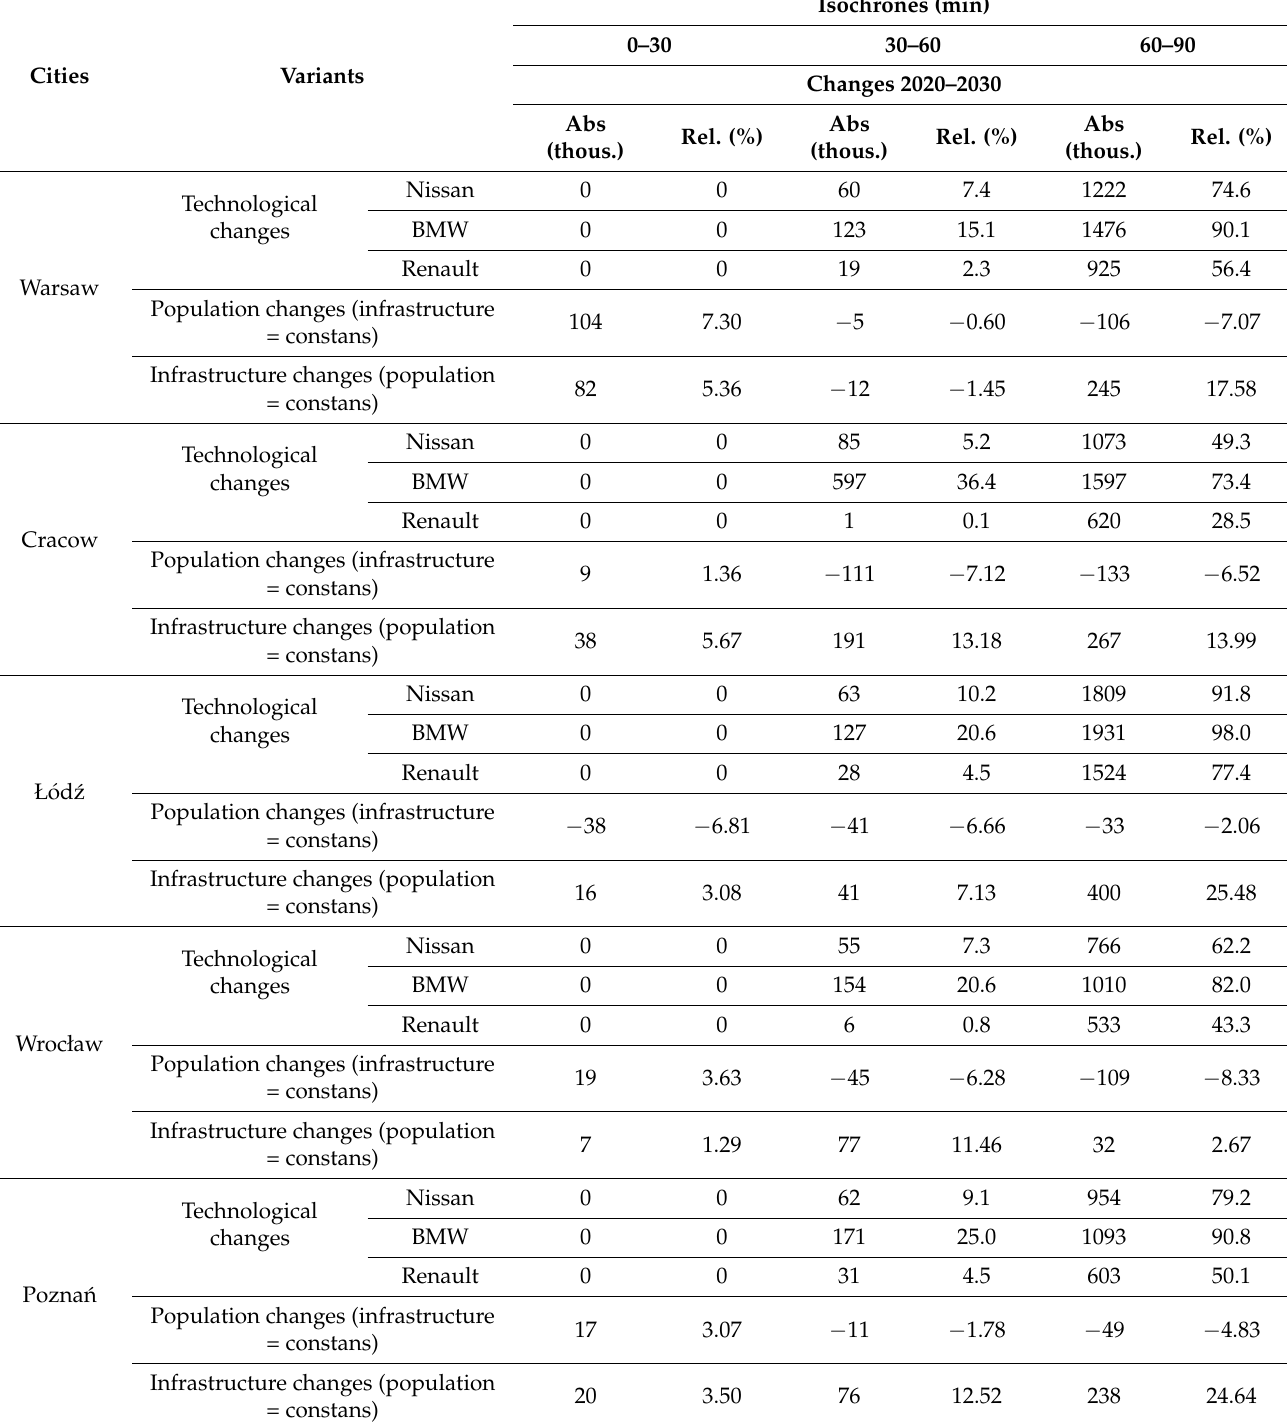
Table 1. Net effect of technological, demographic, and infrastructural change calculated as absolute and percentage change in the size of working age population in the 0–30/30–60/60–90 min isochrones for travel to the centers of the five largest cities in